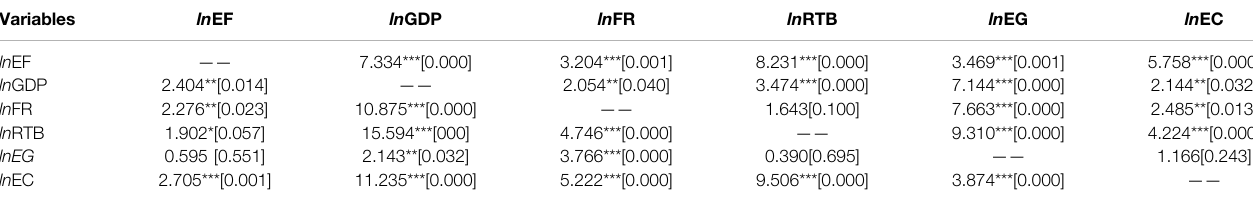
TABLE 9 | The DH non-causality test